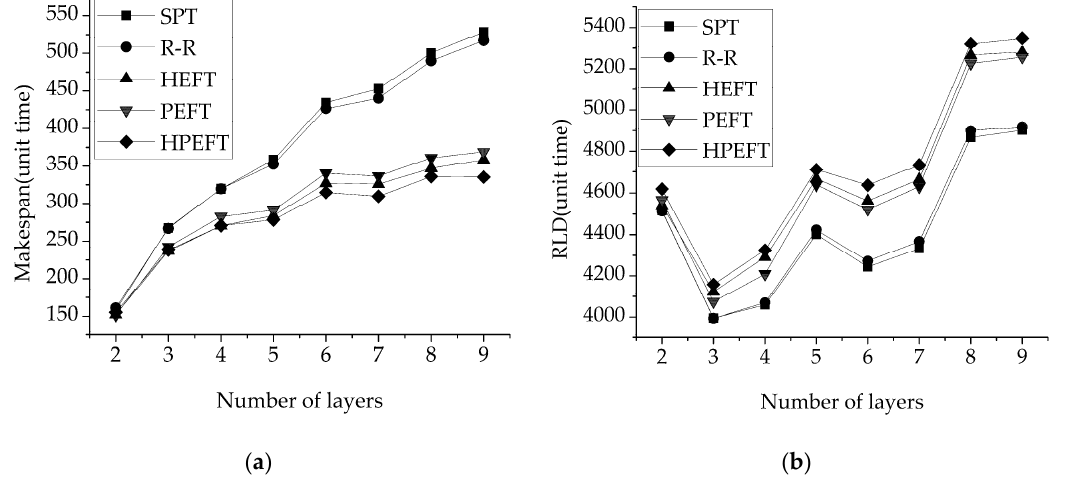
Figure 10. Variable number of layers: ( a ) makespan and ( b ) RLD.